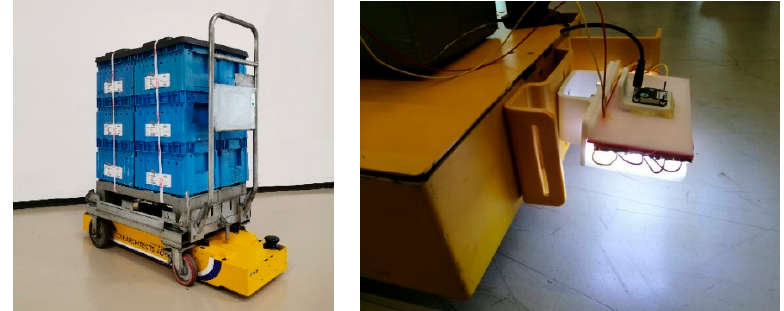
Figure 1. On the left, an autonomous omnidirectional vehicle being experimented in an industrial setting for moving carts between different zones of a factory; on the right, a close view to the vision-based system used to aid in robot localization.